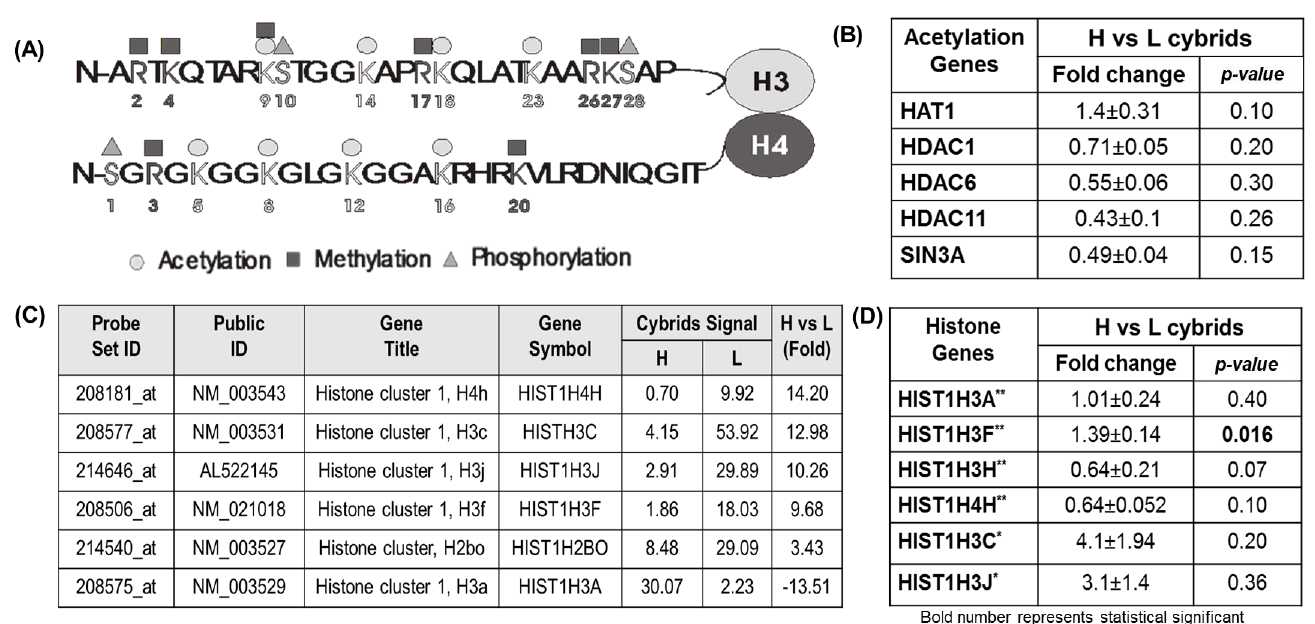
Figure 4. Assessing the acetylation status of cybrids from European (H) and African (L) ancestry. ( A ) A schematic representation of the sites where epigenetic modification occurs in the N-terminus portions of the histones H3 and H4. ( B ) Acetylation gene expression levels in H cybrids versus L cybrids. When compared to H cybrids, fold-change values larger than 1 indicate gene upregulation and those less than 1 indicate gene downregulation. The value 1 is assigned to H cybrids. ( C ) Affymetrix Chip data comparing H cybrids versus L cybrids for histone genes. ( D ) Histone gene expression levels in H cybrids versus L cybrids. As mentioned above, the fold-change value representation is employed. European-H cybrids (* n = 5) and African-L cybrids (n = 5), with three values for each sample, European-H cybrids (** n = 5) and different African-L cybrids (n = 5), with three values for each sample.